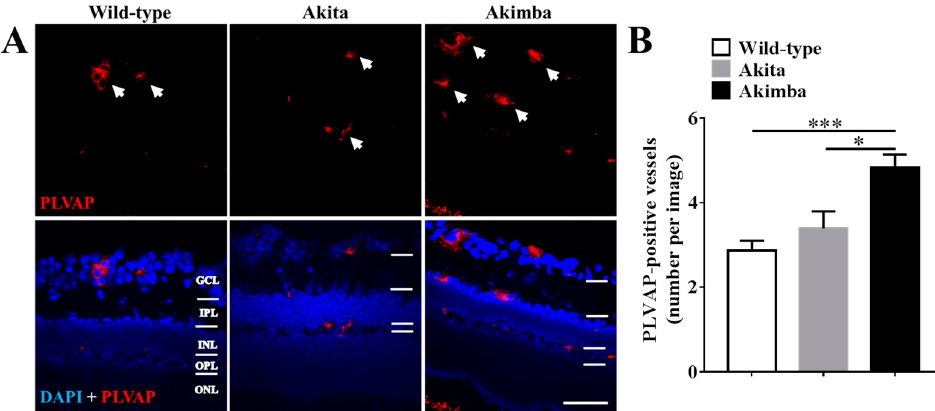
Figure 4. PLVAP-positive vessels in wild-type, Akita, and Akimba mice. ( A ) PLVAP (red) expression within retinal layers in wild-type, Akita, and Akimba mice. PLVAP-positive vessels are indicated by white arrows. GCL = ganglion cell layer; IPL = inner plexiform layer; INL = inner nuclear layer; OPL = outer plexiform layer; ONL = outer nuclear layer. Scale bar: 50 µm; ( B ) Quantification of PLVAP-positive vessels shows that there was no difference in vessel number between wild-type and Akita retinas ( p = 0.4511). However, there were more PLVAP-positive vessels within the retina of Akimba mice compared to wild-type ( p = 0.0005) and Akita ( p = 0.0154) mice. Data presented as mean + SEM. Statistical comparisons were carried out using one-way ANOVA with Tukey’s multiple comparisons test; n = 4 animals/group; * p ≤ 0.05, *** p ≤ 0.0001.